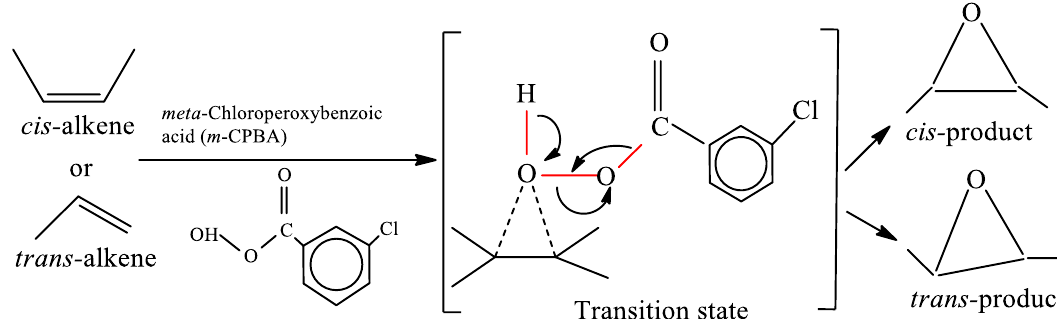
Figure 1. Chemical reaction mechanism of the meta -chloroperoxy benzoic acid ( m -CPBA)/block copolymer (BCP) system.